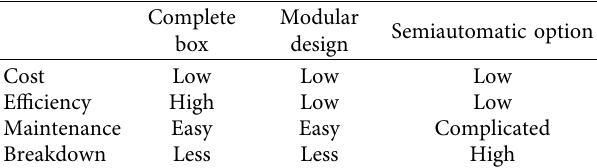
Table 29: Possible